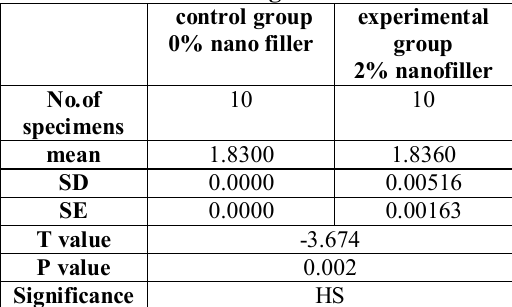
Table 4: surface roughness test results